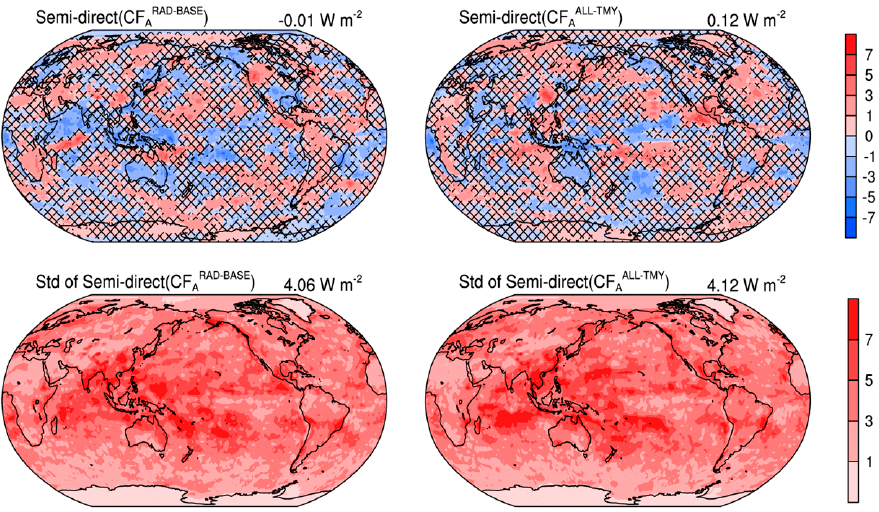
Figure 3. Annual mean anthropogenic aerosol (year 2000) semi-direct effect ( upper panels ) and corresponding standard deviations calculated from the difference of each year ( lower panels ). The results calculated from the differences between the RAD and BASE experiments are presented in the left-hand column. The results calculated from the differences between the ALL and TMY experiments are presented in the right-hand column. The global average is given in the upper-right corner. Hatching represents the nonsignificant area at the 90% confidence level of Student’s t -test. Note: that the colorbar of the radiation variable is different from that in the other figures.